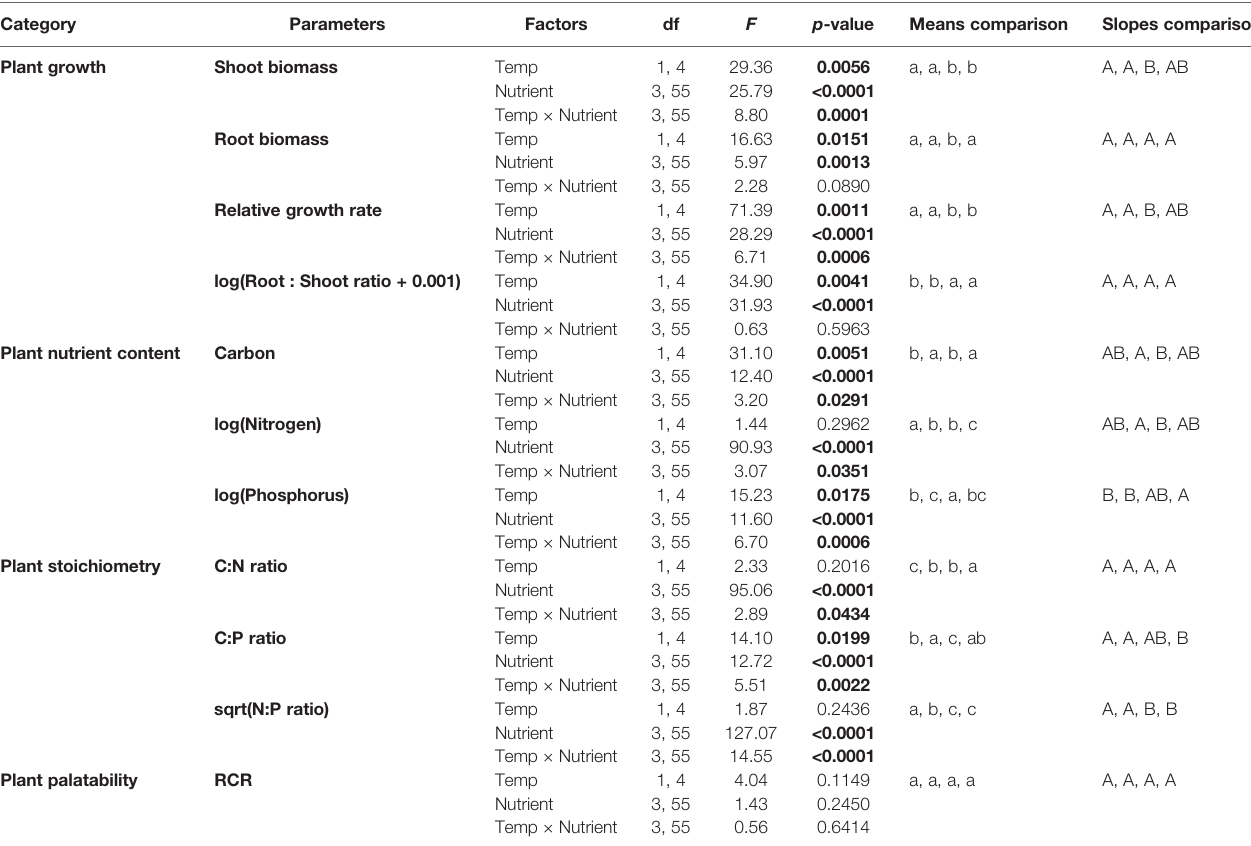
Means and slopes comparison among the four nutrient treatments were performed after each linear mixed-effect model test. Different letters indicate differences among the four nutrient treatmentsinanorderofW0.S0,W1.S0,W0.S1andW1.S1,thesameorderaspresentedin Figures2 – 6 . “ Temp ” representstemperaturetreatment. “ Nutrient ” indicatesthefournutrient treatments. “ RCR ” represents plantrelative consumption rate. “ log ” and “ sqrt ” indicate the data are natural log and square root transformed respectively. Bold numbers indicate p <